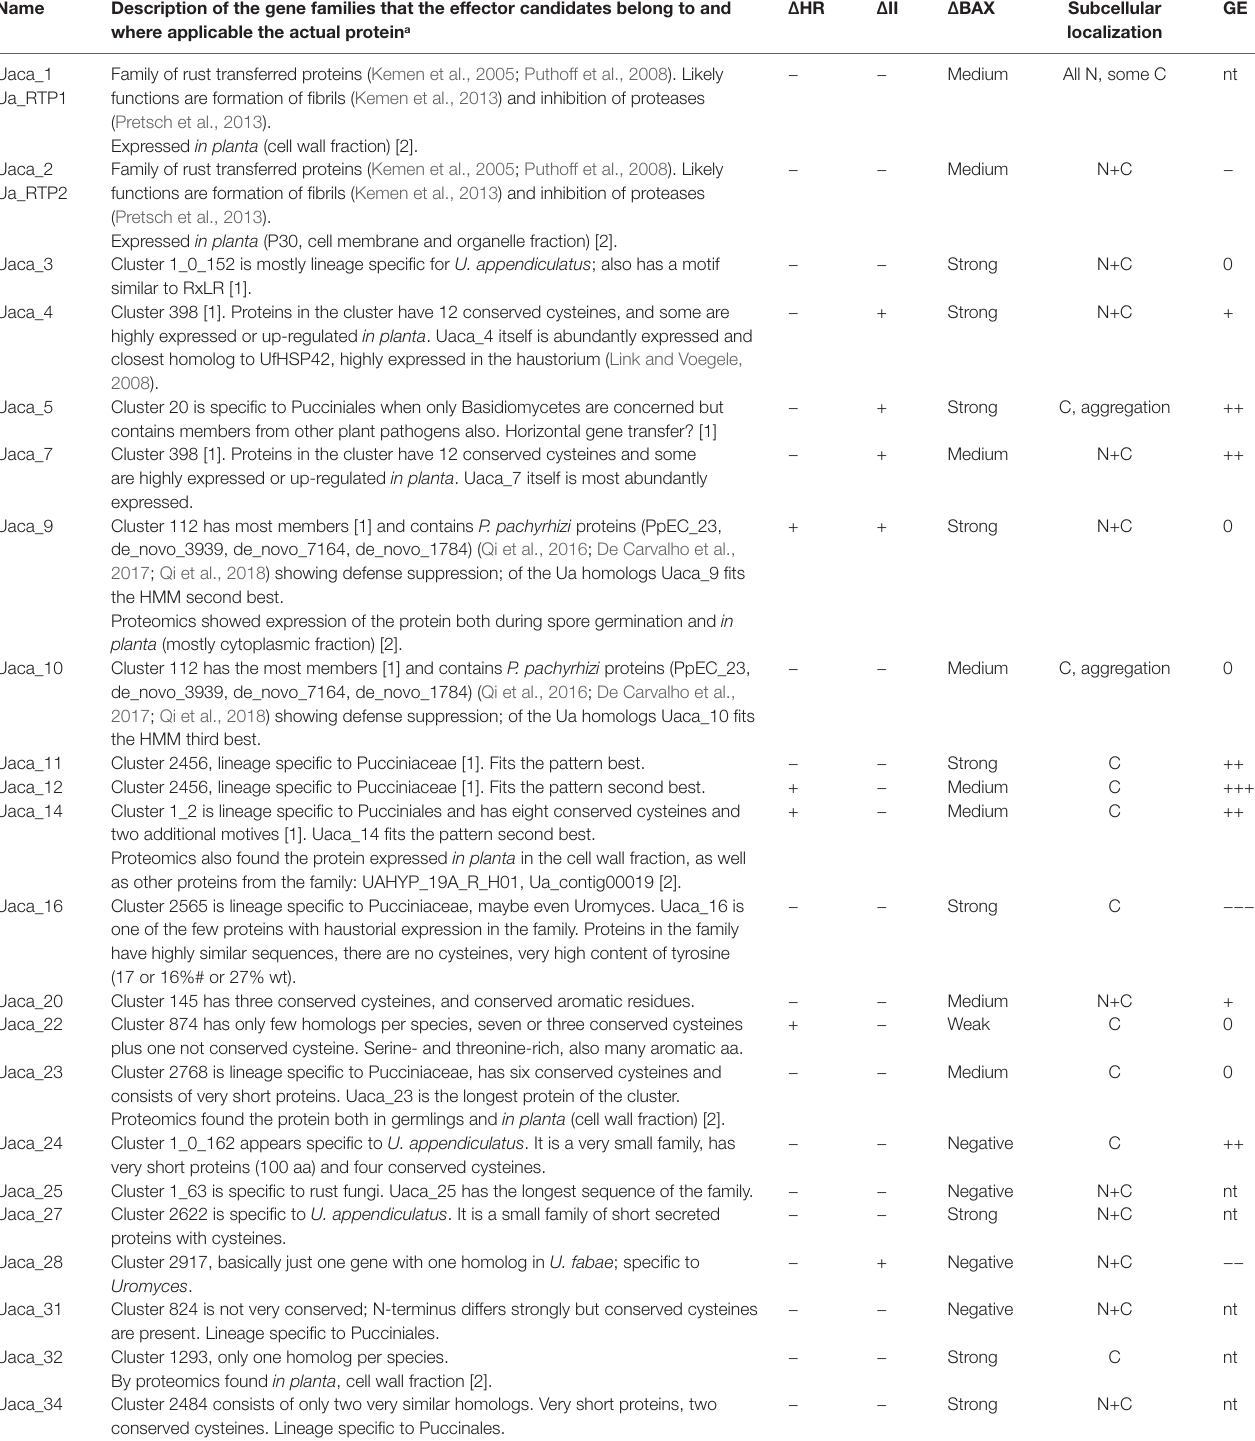
TABLE 2 | Effector candidates and results of the experimental assays. ΔHR, suppression of the hypersensitive response; ΔII, suppression of innate immunity; ΔBAX, suppression of yeast cell death. Subcellular localization and predicted subcellular localization (Pred): C, cytoplasm; N, nucleus; GE, gene expression; 0, no regulation, expression levels vary less than tenfold; − in planta down-regulation; + in planta up regulation (−/+ > tenfold, −−/++ > hundredfold, −−−/+++ > thousandfold; nt, not